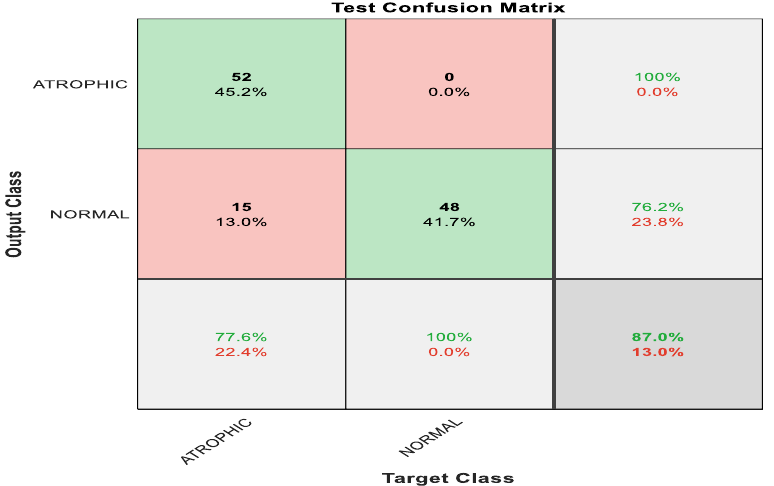
Figure 6. Confusion matrix with results analyzed from the testing data executed via pre-trained Figure 6. ShuffleNet.